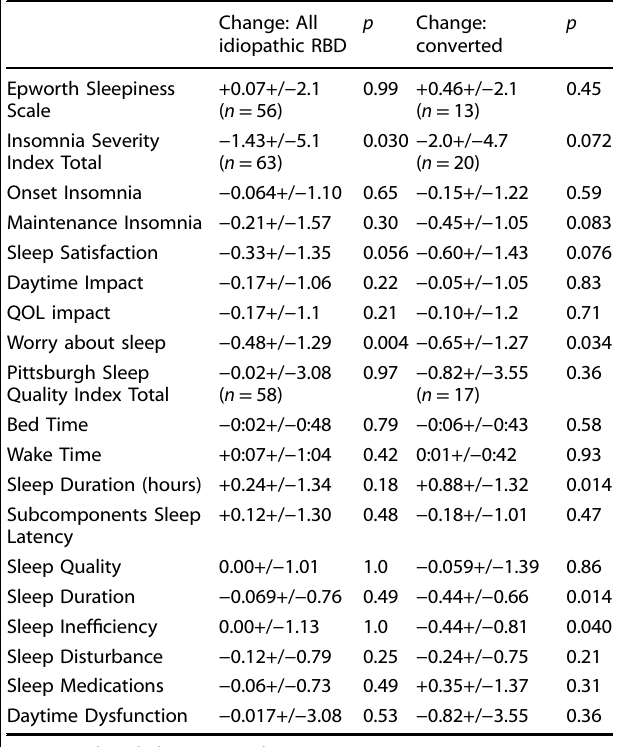
Table 2. Change in Sleep Scale Scores over time Change: All idiopathic RBD